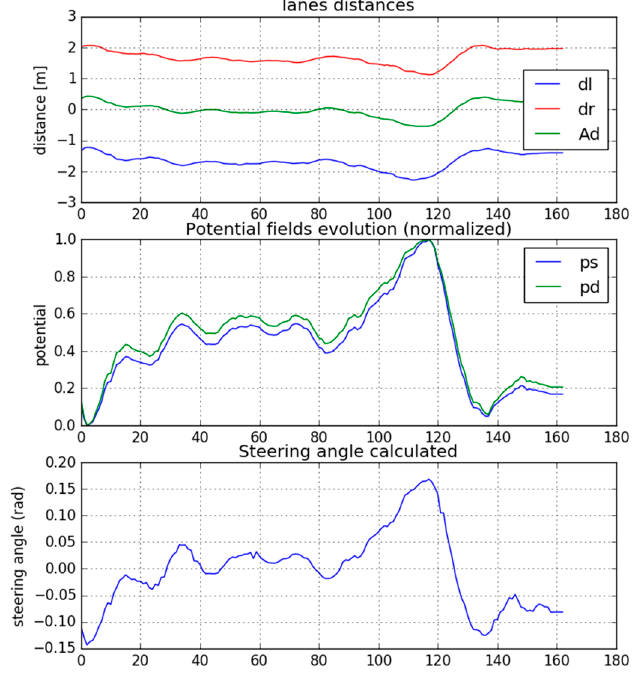
Figure 10. Lateral planning using potential fields.